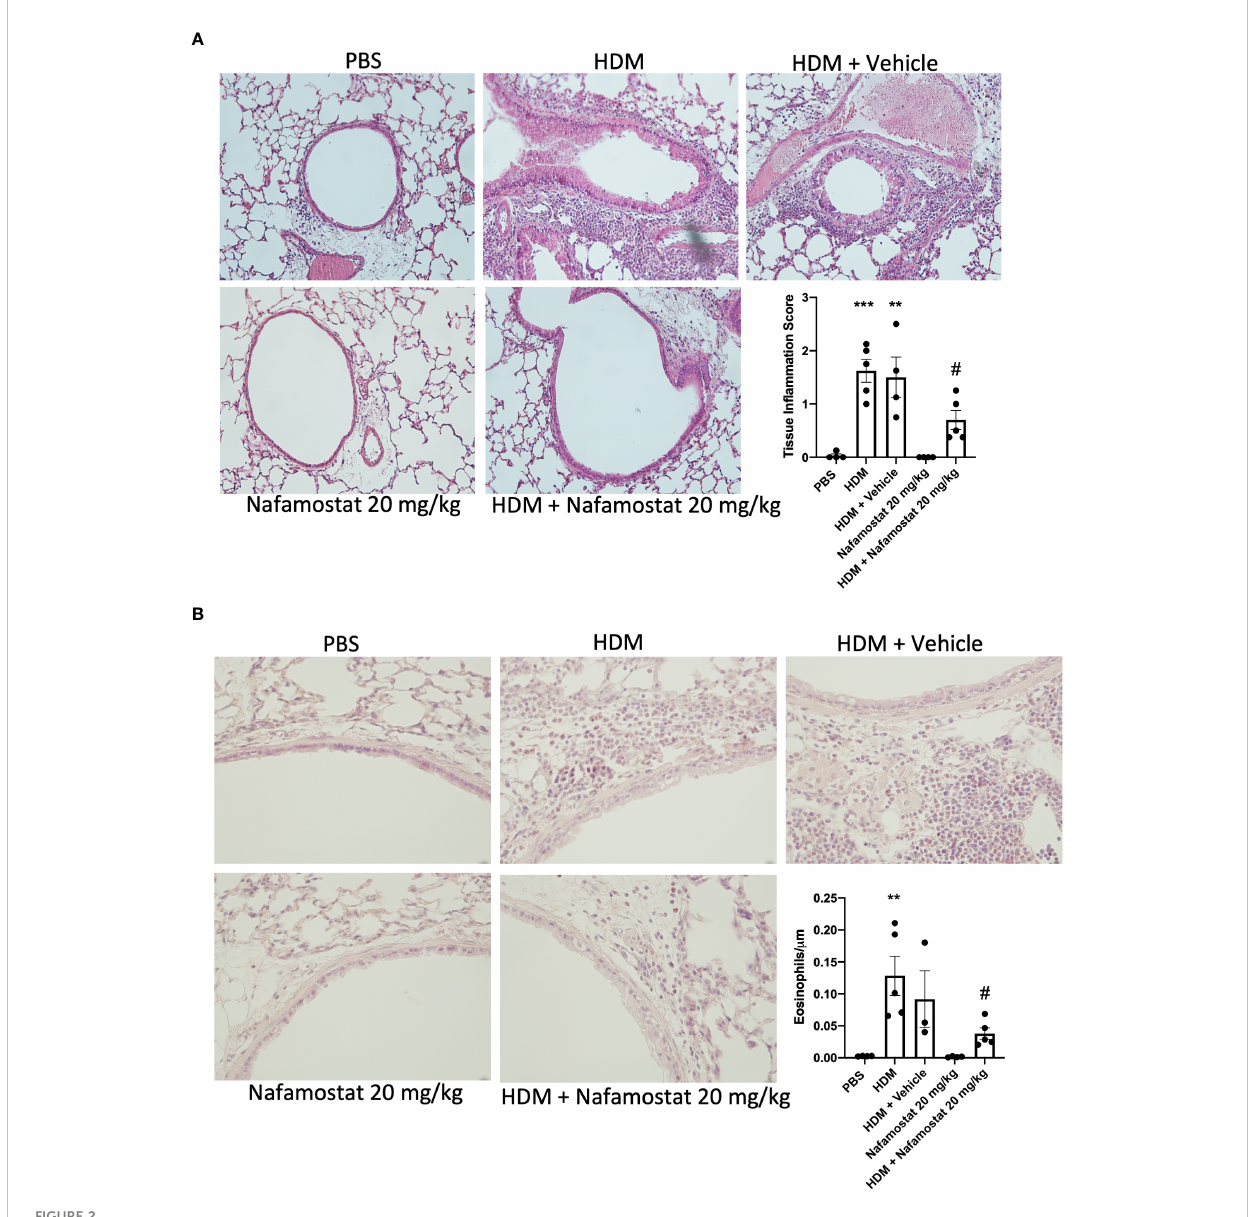
FIGURE 2 Effects of nafamostat on lung peribronchial in fl ammation and eosinophil in fi ltration in HDM-induced experimental asthma. Mice received either PBS or HDM extract twice a week for 6 weeks. Mice were treated with vehicle or with nafamostat (20 mg/kg) 30 min prior to each HDM instillation. Control mice were treated with PBS only. Peribronchial in fl ammation (A) and eosinophil in fi ltration around the airways (B) were assessed by hematoxylin and eosin (H&E) and chromotrope 2R staining, respectively. Representative images for H&E (x 20 original magni fi cation) and chromotrope 2R staining (x 40 magni fi cation) are shown. Data represent mean values ± SEM. ** P < 0.01, *** P < 0.001 vs. the PBS group. # P < 0.05 vs. the HDM group. n = 3 – 5 mice per group. HDM, house dust